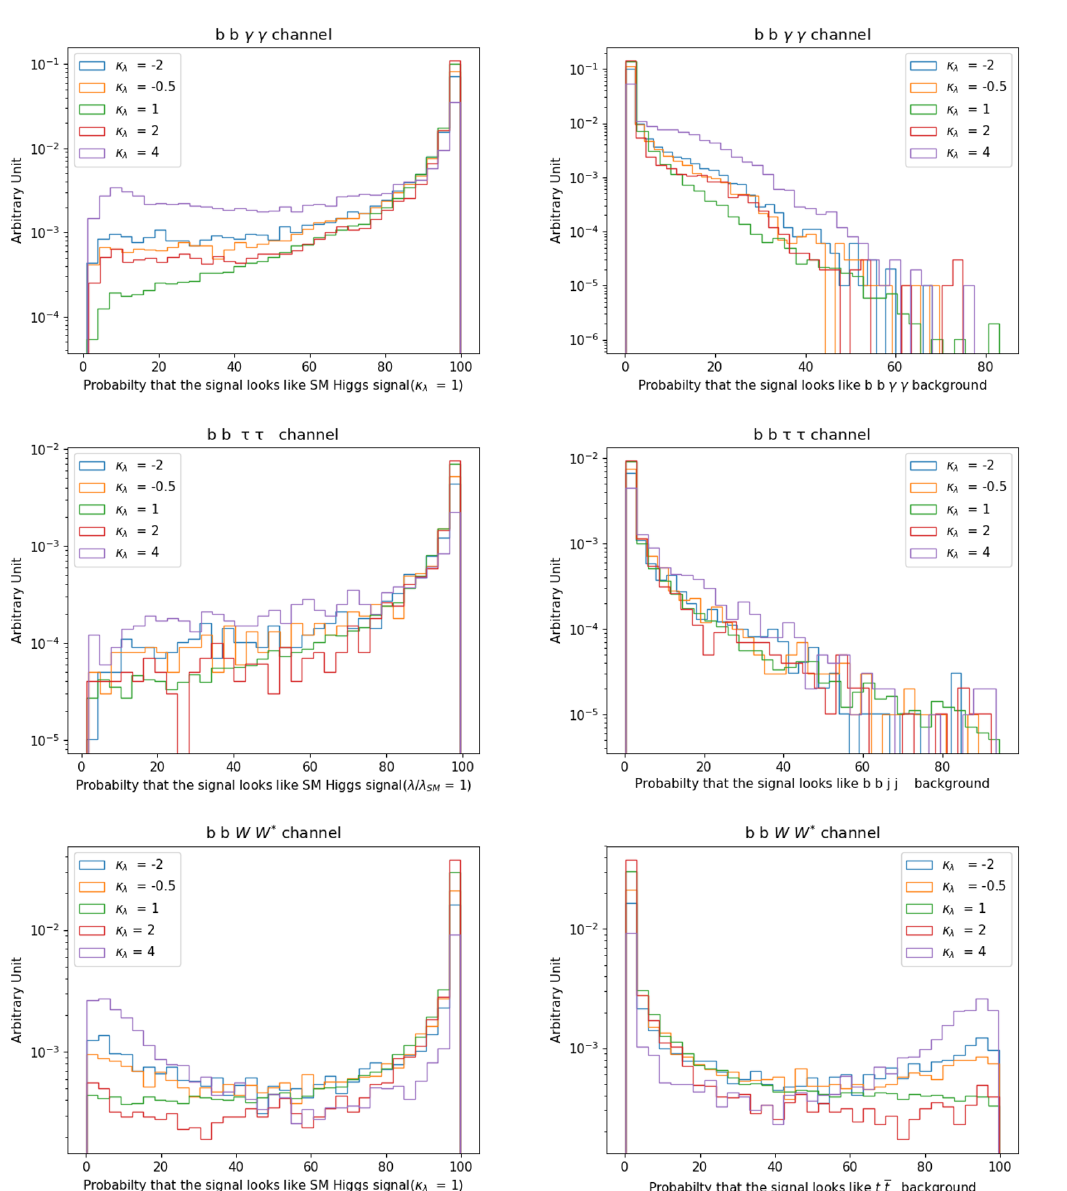
Figure 16 . Normalized distributions illustrating the probability that the signal events in the b ¯ bγγ (top), b ¯ bττ (center) and b ¯ bWW ∗ (bottom) channel look like the respective SM di-Higgs signal (shown in the left panels) and respective dominant SM backgrounds (shown in the right